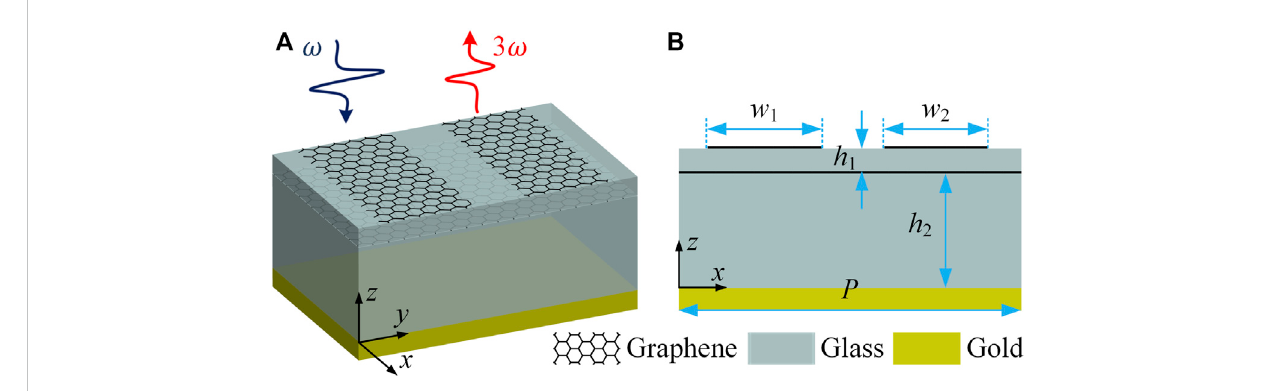
FIGURE 1 (A) Schematic of the designed terahertz non-linear metamaterial. (B) Cross-section of the metamaterial with geometric